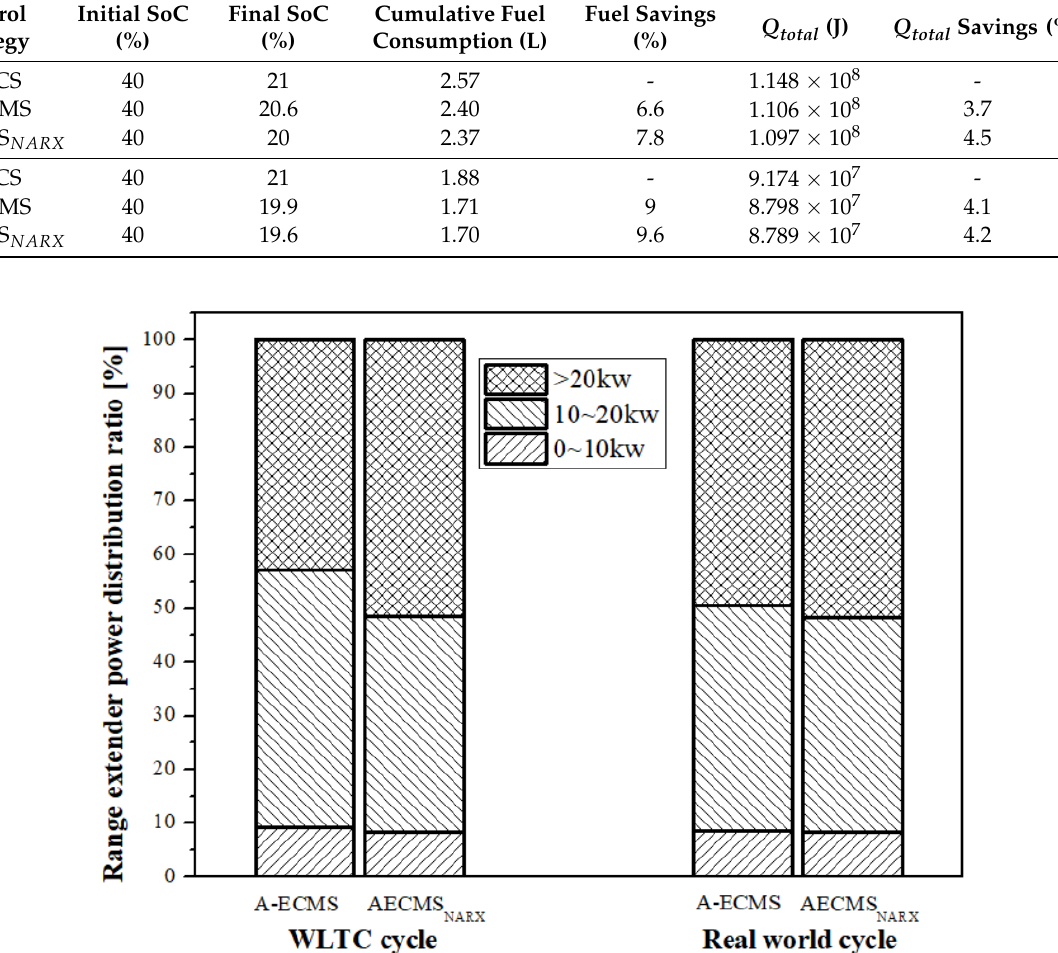
Table 7. Summary of vehicle performance comparison.